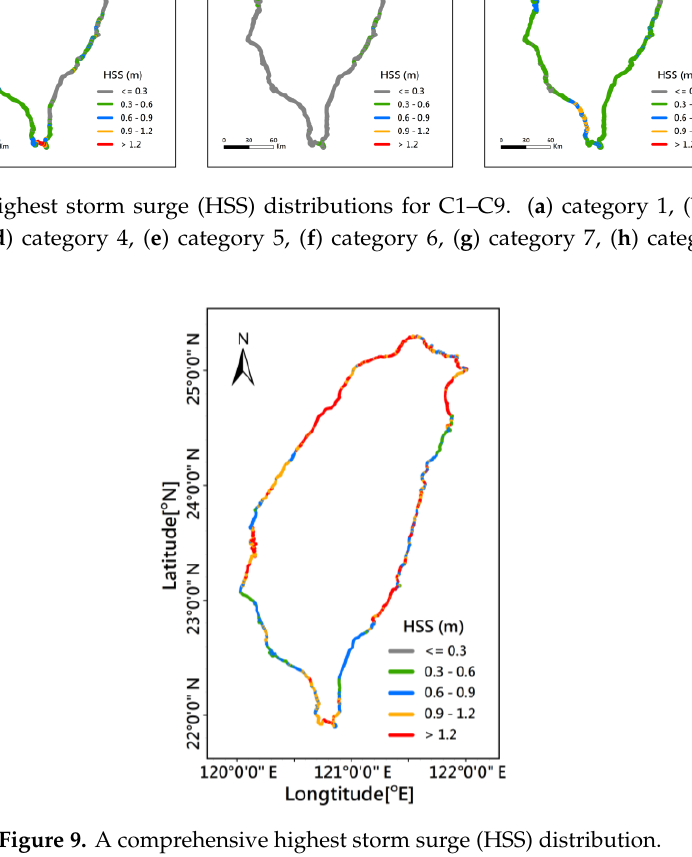
Figure 9. A comprehensive highest storm surge (HSS) distribution .